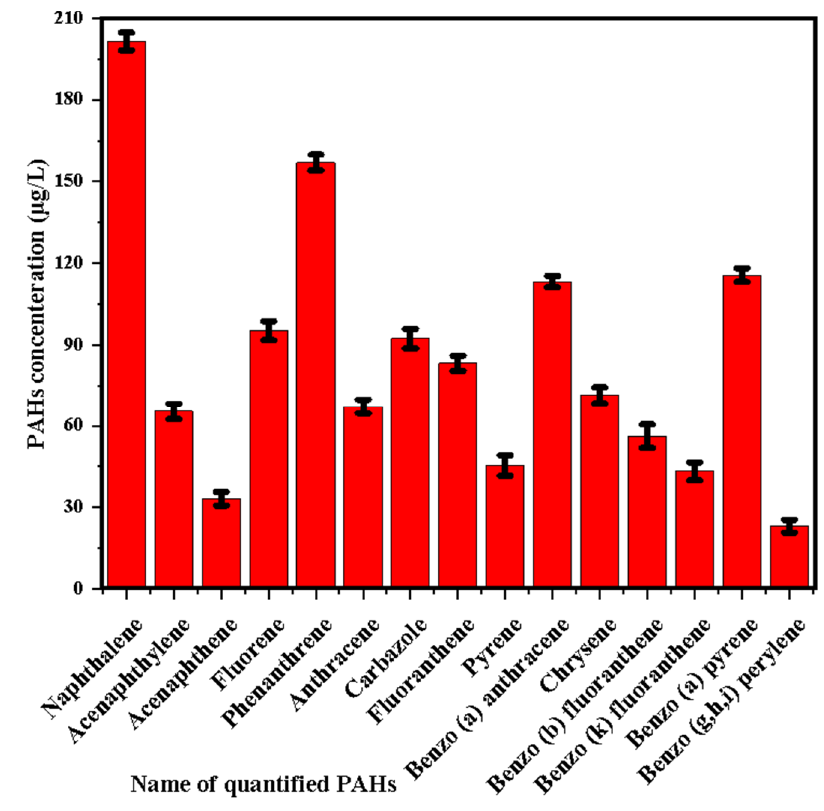
Figure 1. The concentration profiles of different polycyclic aromatic hydrocarbons (PAHs) characterized in real produced water.